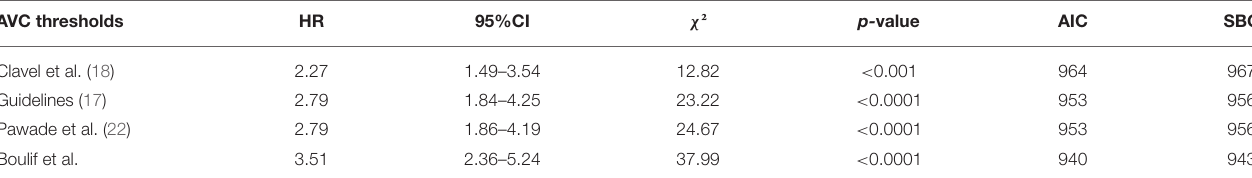
TABLE 6 | Prognostic accuracy of severe calcification in patients with concordant echocardiographic grading.